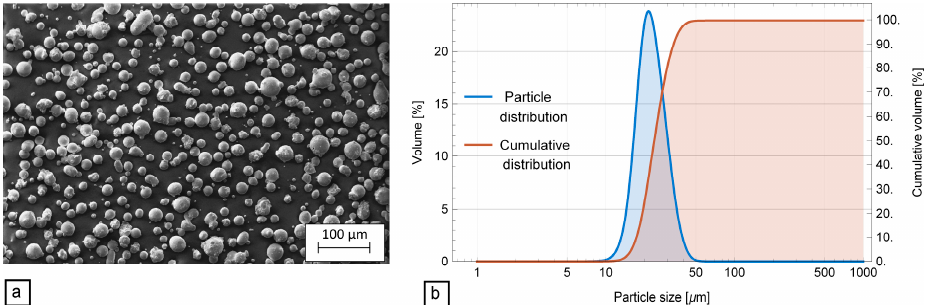
Figure 2. SEM image of Inconel718 powders ( a ); granulometry distribution ( b ). Table 2. Chemical composition of Ti64Al4V.